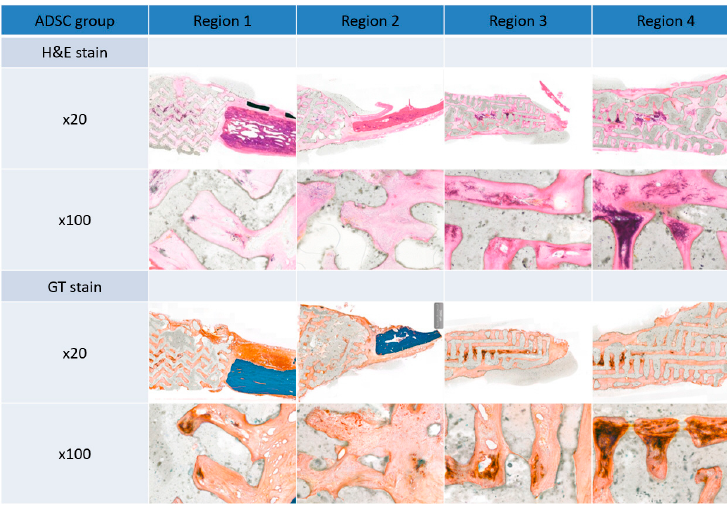
Figure 7. Histopathological analysis of the adipose-derived stem cell (ADSC) group 12 weeks after surgery by Hematoxylin and Eosin (H&E) and Goldner’s trichrome (GT) staining. Original magnification: ×20 and ×100.